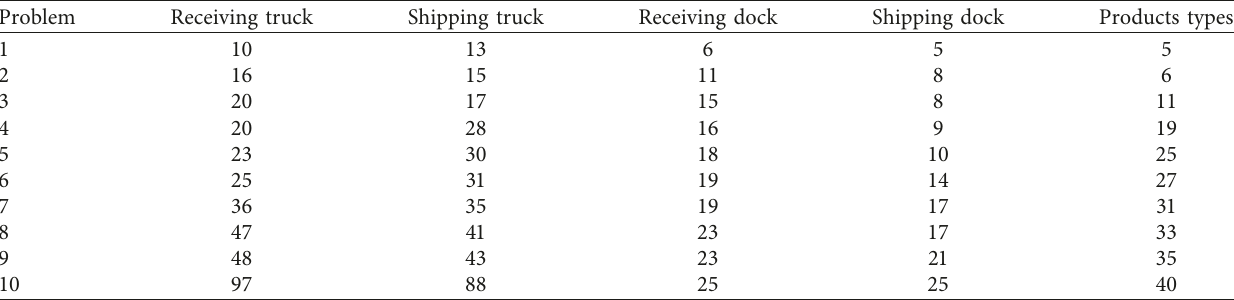
Table 3: Numerical examples of different sizes.